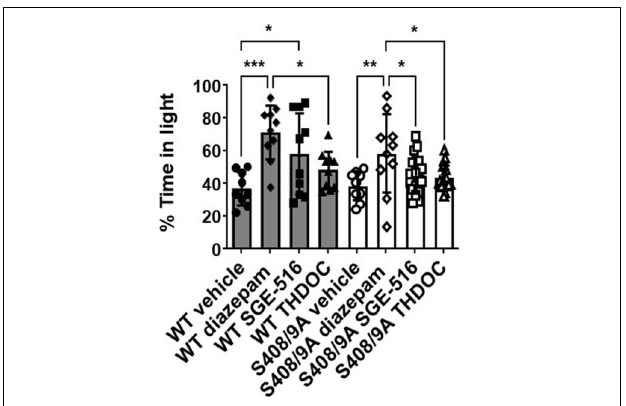
FIGURE 2 | S408/9A selectively impairs the anxiolytic effects of neuroactive steroids. Time spent in the light arena of the light-dark box assay was determined for WT (black bars) and S408/9A (white bars) mice with vehicle, diazepam (0.25 mg/kg), SGE-516 (1 mg/kg), or THDOC (10 mg/kg) treatment. In both genotypes, diazepam significantly increased the amount of time spent in the light arena. THDOC was ineffective at increasing time spent in the light whereas SGE-516 increased time in light area only in WT mice. * p ≤ 0.04, ** p = 0.004, *** p = 0.0006; n =